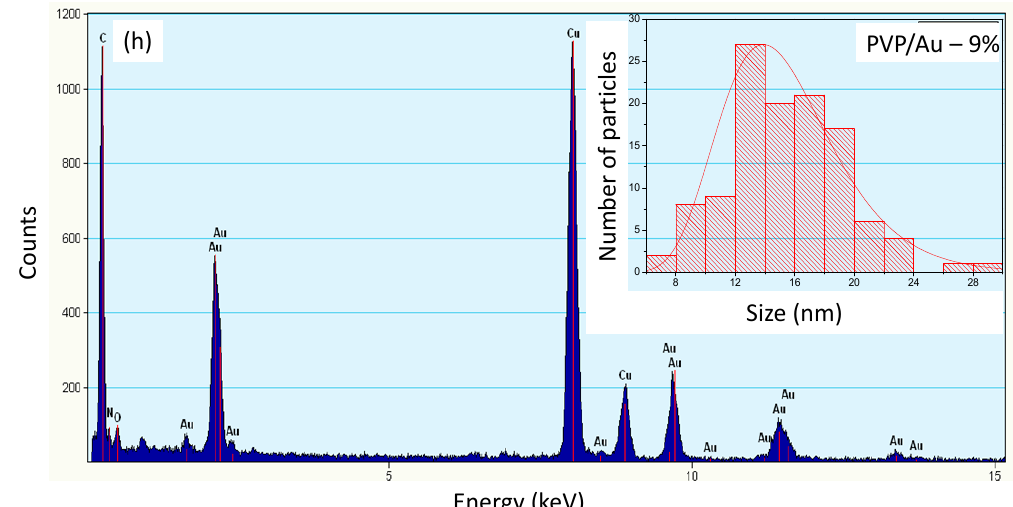
Figure 7. Transmission Electron Microscopy (TEM) bright field images ( a – c ), average Au NP size distribution histogram and Energy Diffraction X-ray (EDX) ( d ) corresponding to the PVP/Au—2% wt system. TEM bright field images ( e – g ), average Au NP size distribution histogram and EDX ( h ) corresponding to the PVP/Au—9% wt system.